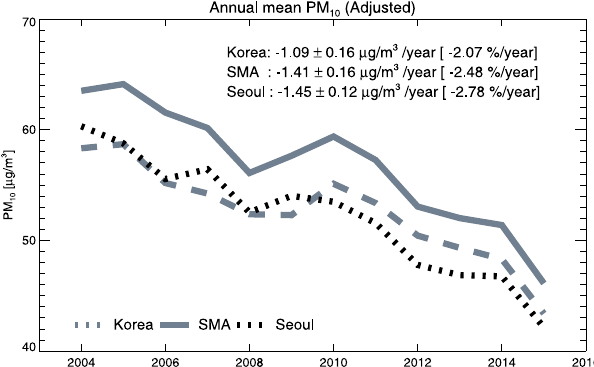
Figure 3. Time series of adjusted surface PM concentrations over Seoul, the SMA, and South Korea. Modeled fractional interannual anomalies (Fig. 2) are applied to remove meteorology-driven interannual variances from the original PM concentrations in Fig.